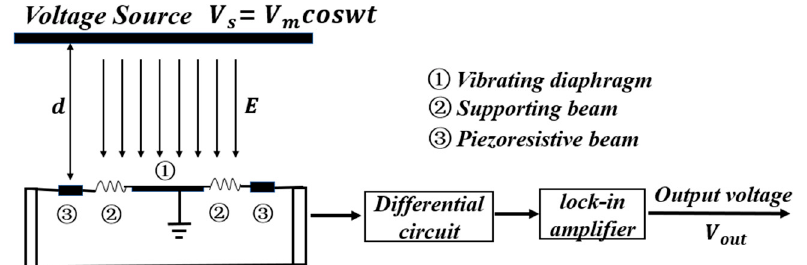
Figure 2. The operating principle of the sensor.